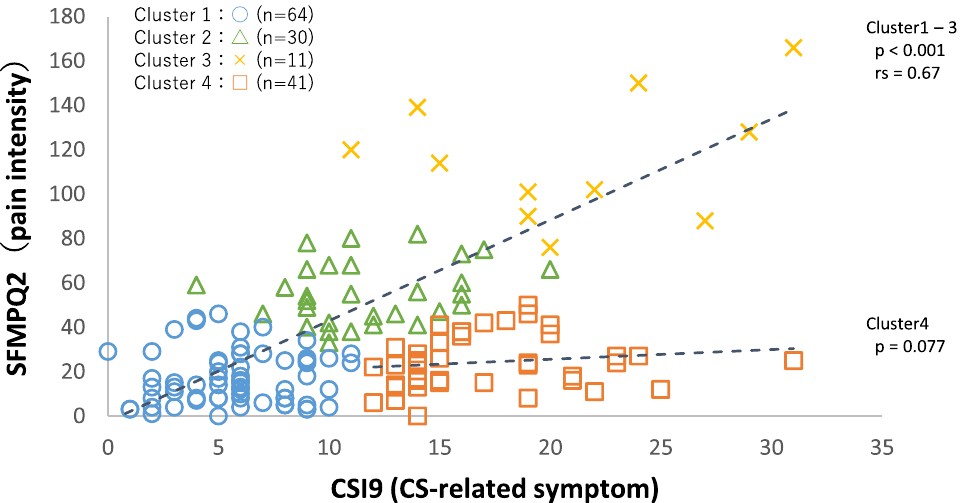
Figure 1. Division into four clusters by k-means cluster analysis. The plotted points indicate cluster 1 (blue circles), cluster 2 (green triangles), cluster 3 (yellow crosses), and cluster 4 (orange squares), respectively. CSI9 central sensitization inventory-9, SFMPQ2 short form McGill pain questionnaire-2. The two trend lines show the regression lines of CSI9/SFMPQ2 for clusters 1, 2, and 3, and cluster 4, respectively. The figure was created using Microsoft Excel for Microsoft 365 MSO (16.0.14026.20202) 32